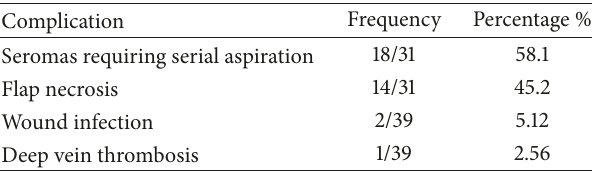
Table 2: Postoperative complications.